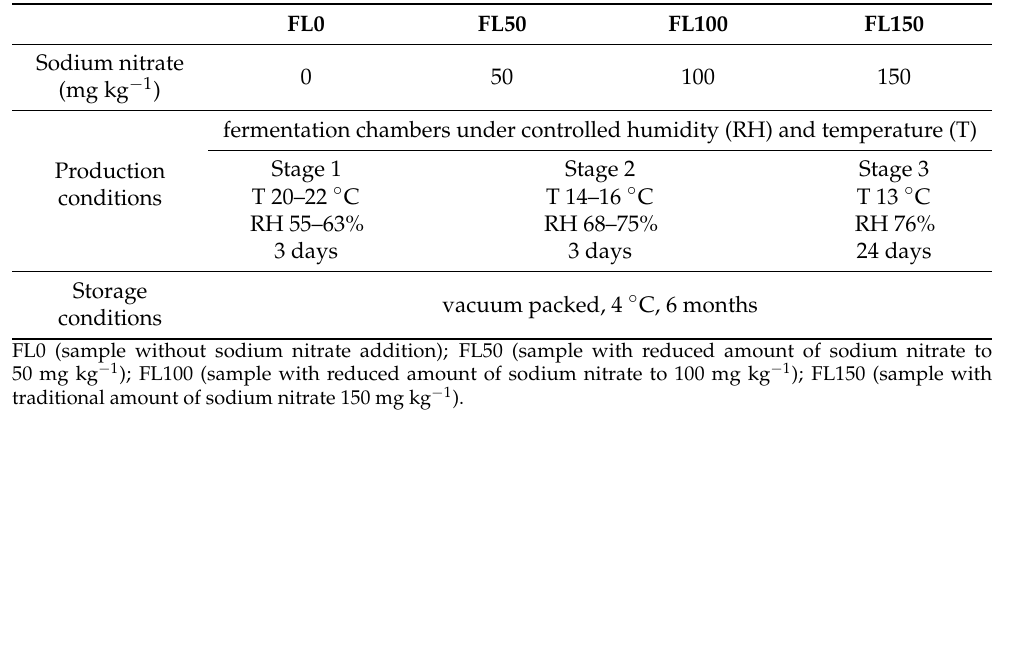
Table 1. Formulations of fermented loin treatment, production and storage